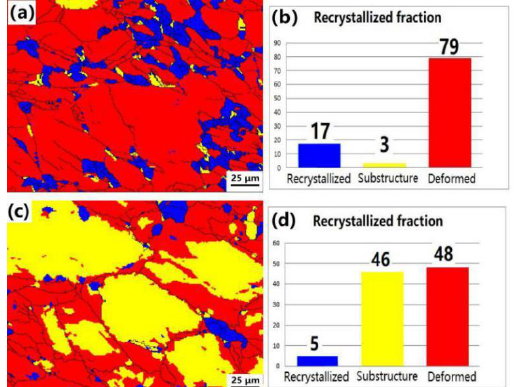
Figure 11. Electron backscattered diffraction (EBSD) results of the specimens under different strain rates: ( a ) deformation recrystallization at a strain rate of 0.01 s −1 , ( b ) recrystallized fraction at a strain rate of 0.01 s −1 , ( c ) deformation recrystallization at a strain rate of 10 s −1 and ( d ) recrystallized fraction at a strain rate of 10 s −1 .